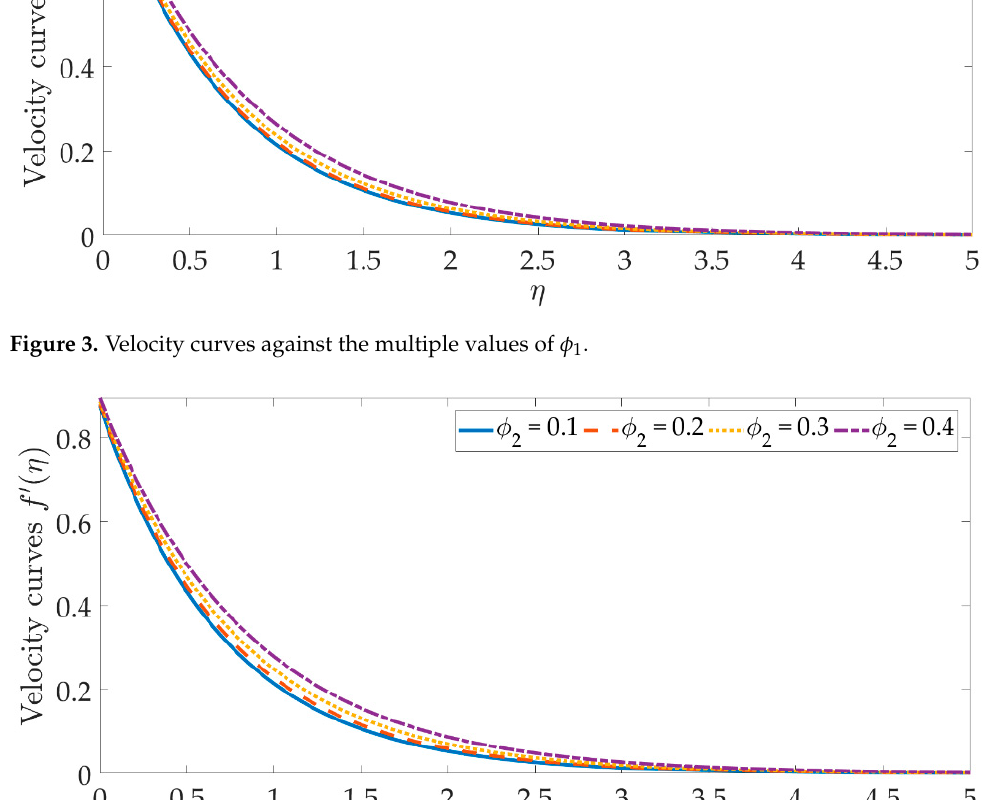
Figure 4. Velocity curves against the multiple values of φ 2 .